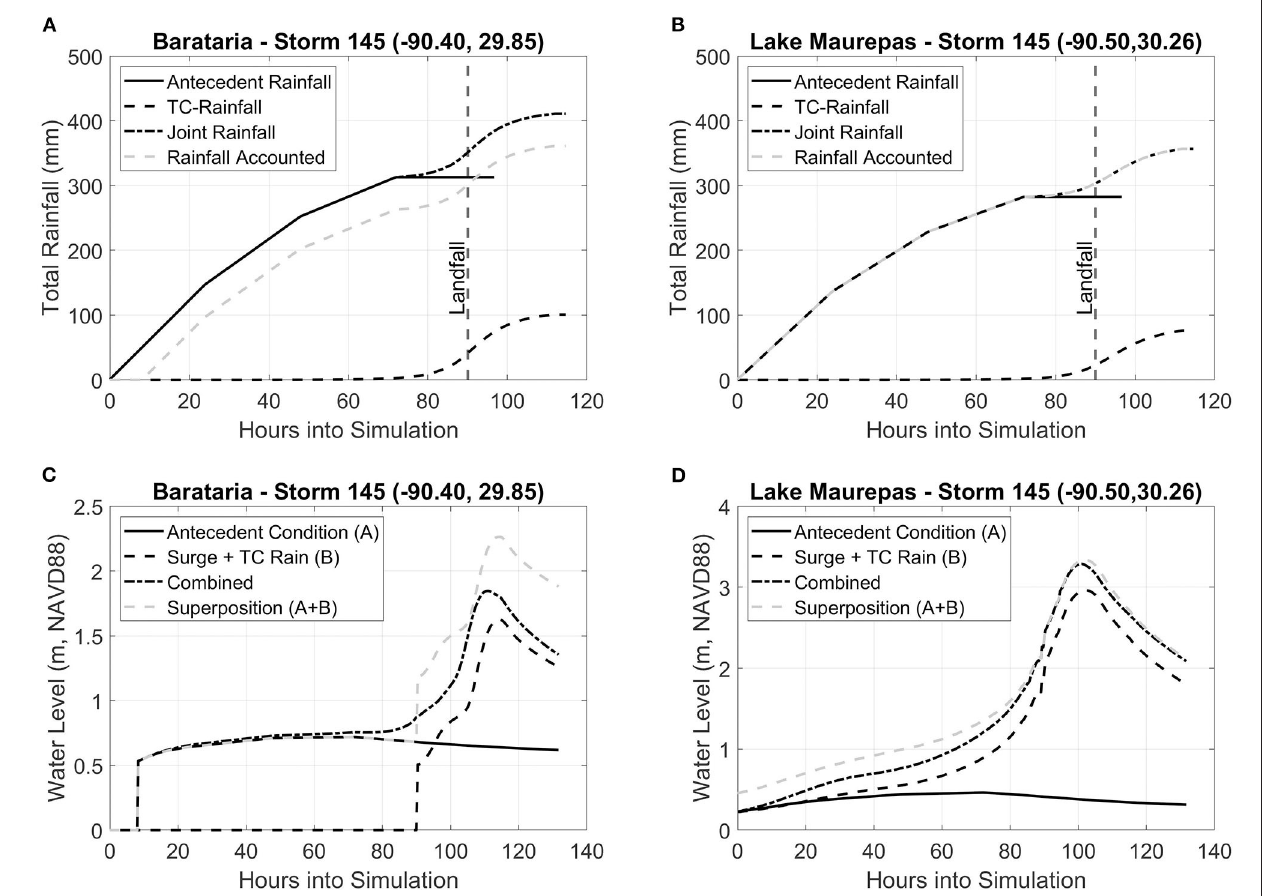
FIGURE 5 | Total rainfall accumulation hyetograph for synthetic storm 145 within the (A) Barataria watershed and (B) Lake Maurepas. Locations are shown in Figure 2 (B3 and M6). Storm 145 makes landfall at 90h (vertical dashed line). Water surface elevation (m, NAVD88) for synthetic storm 145 within the (C) Barataria watershed and (D) Lake Maurepas. Water levels from antecedent rainfall only (no surge) is shown as the solid black line. Water levels for storm surge and TC-driven rain (no antecedent rain) is shown as the dashed black line. Water levels for a combined storm surge, TC-driven rain, and antecedent rain is shown as the dash-dot black line. A superposition of the individual curves from the antecedent and surge with TC-rain is shown as the gray dashed